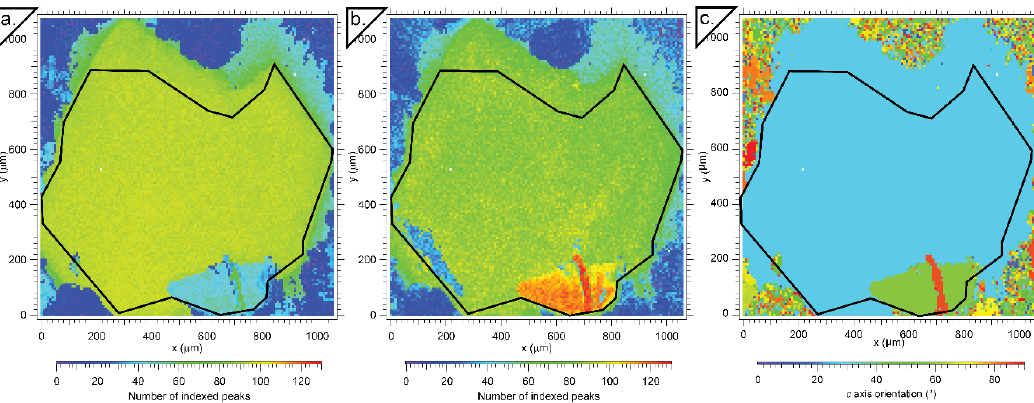
Figure 5. The SiC2 grain indexed as ( a ). 4H-SiC and ( b ). 6H-SiC. ( c ). The c-axis orientation with respect to the sample normal shows several different orientations are present in this sample. The black outline indicates the surface expression of the sample, based on microscopy images.